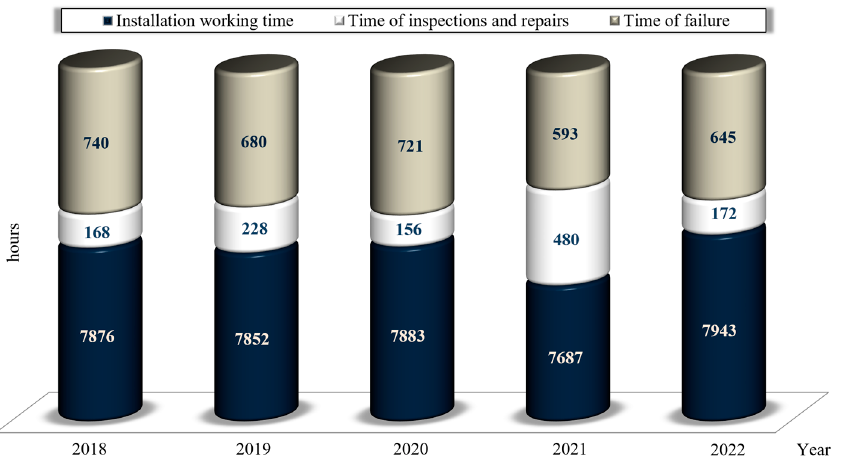
Figure 2. Cogeneration unit’s running, inspection, heavy repair, and failure time in the various years of operation.